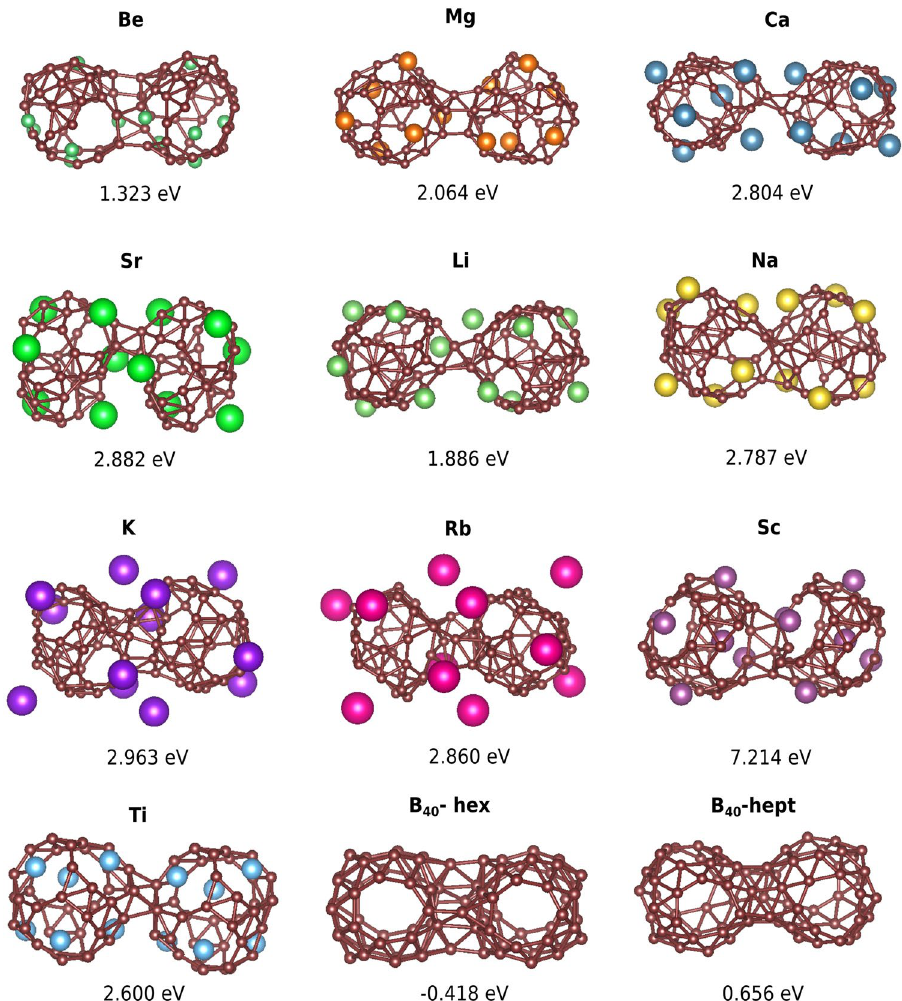
Figure 4. The relaxed structures of dimers made from the lowest energy structures of different M 6 B 40 ’s and B 40 ’s together with their dimerization energy (in eV). All the calculation have been done using BigDFT and the PBE exchange correlation functional. B 40 -hex represents dimer formed along the hexagonal rings and B 40 -hept represents dimer formed along heptagonal